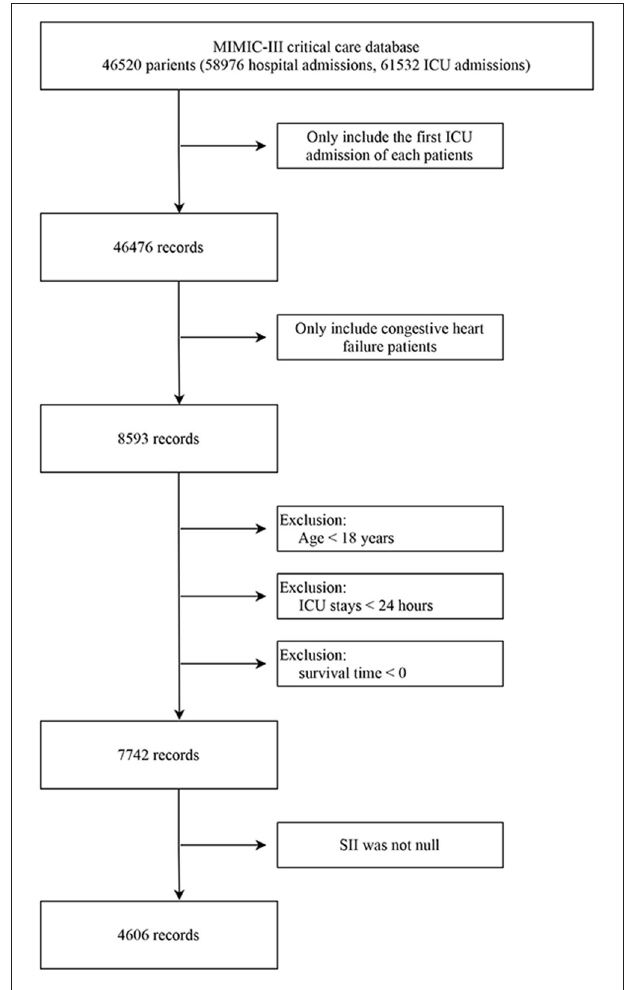
FIGURE 1 | Workflow of exclusion and inclusion as utilized to select the final 4,606 patients. ICU, intensive care unit. SII, systemic immune-inflammation